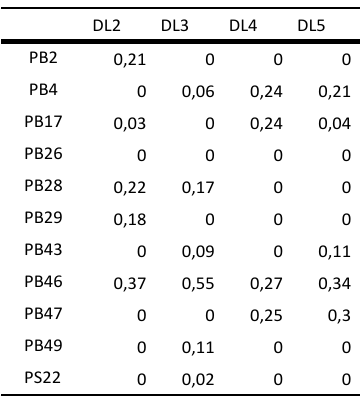
Table 4. Matrix MPBDL: Importance weightings, of all alternatives, with respect to each